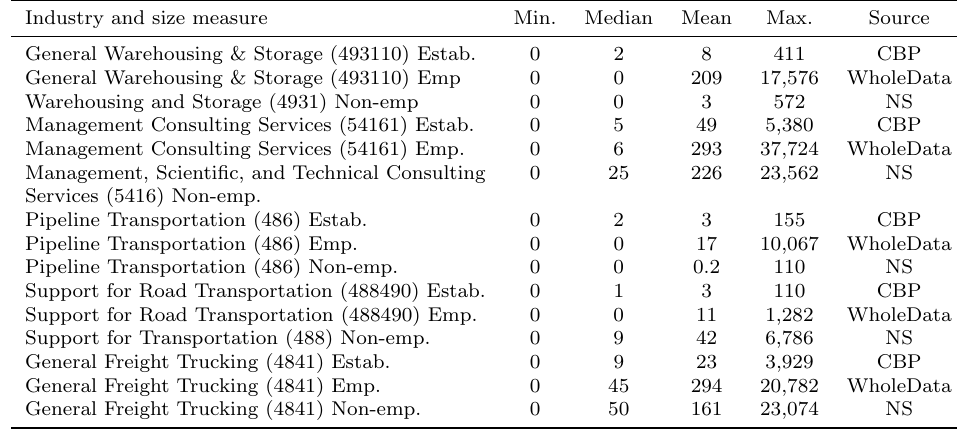
Table A.2: Additional TW Industry Summary Statistics Industry and size measure